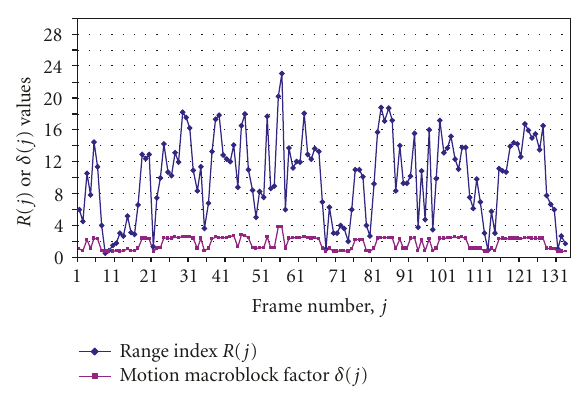
Figure 6: Motion macroblock factor and range index analysis for the “Students” stream.